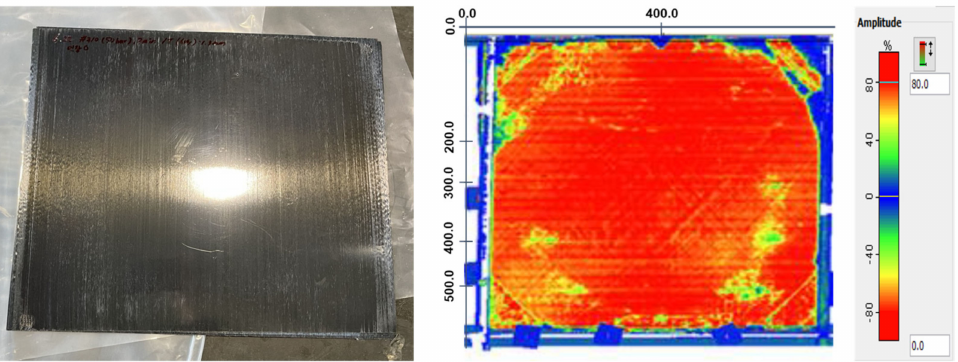
Figure 6. Photograph and C-scan image of a CF/PPS composite (processing temperatures of 280 ◦ C).